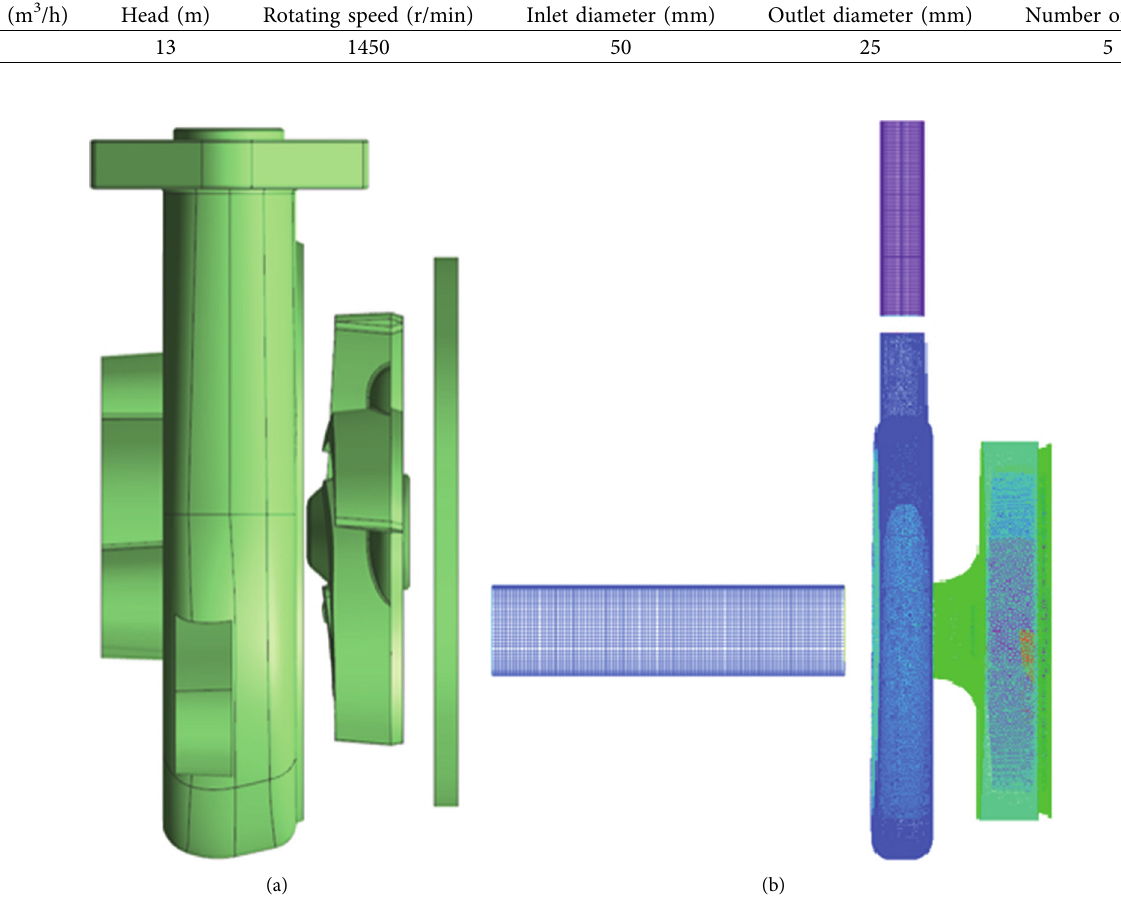
Figure 1: Centrifugal pump model and grid. (a) Centrifugal pump model; (b) centrifugal pump grid.